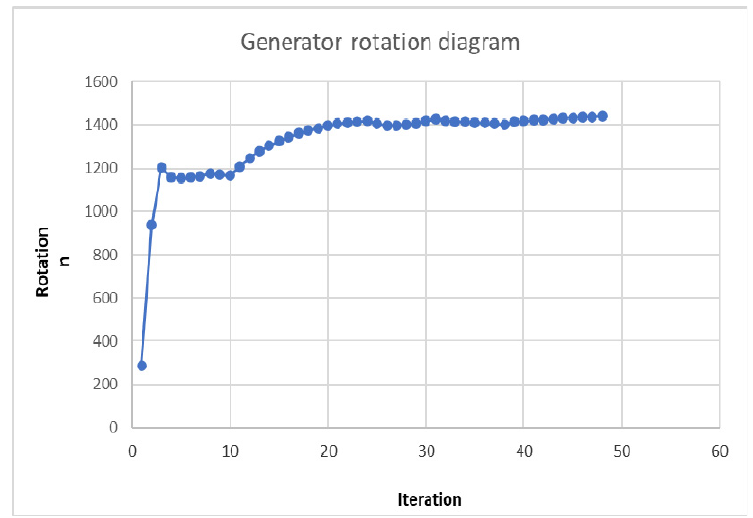
Figure 18. Generator rotation diagram.